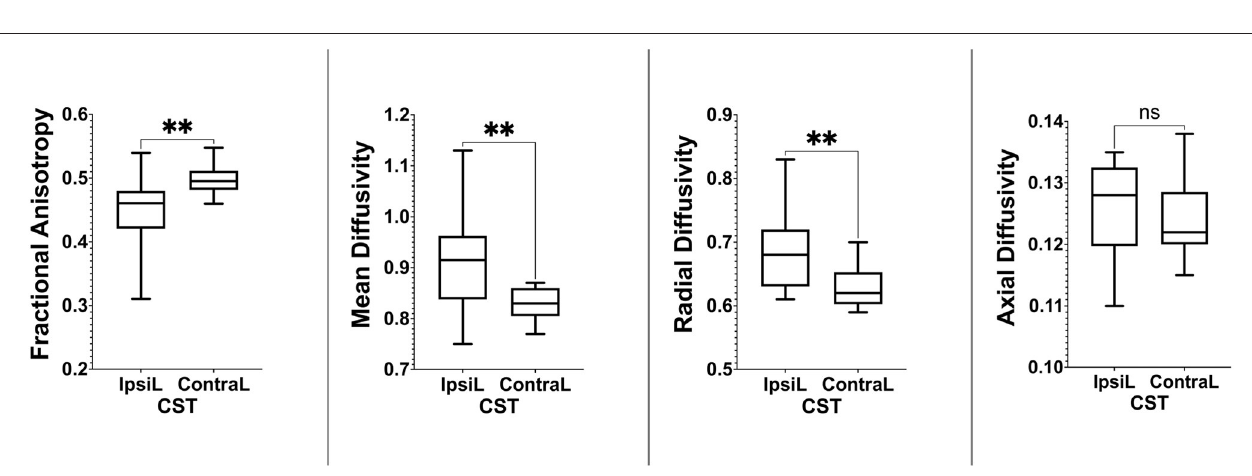
FIGURE 5 | Boxplots showing statistically significant differences in fractional anisotropy, mean diffusivity, and radial diffusivity between the ipsilesional and contralesional side only with the CSD-Prob approach. ** P ≤